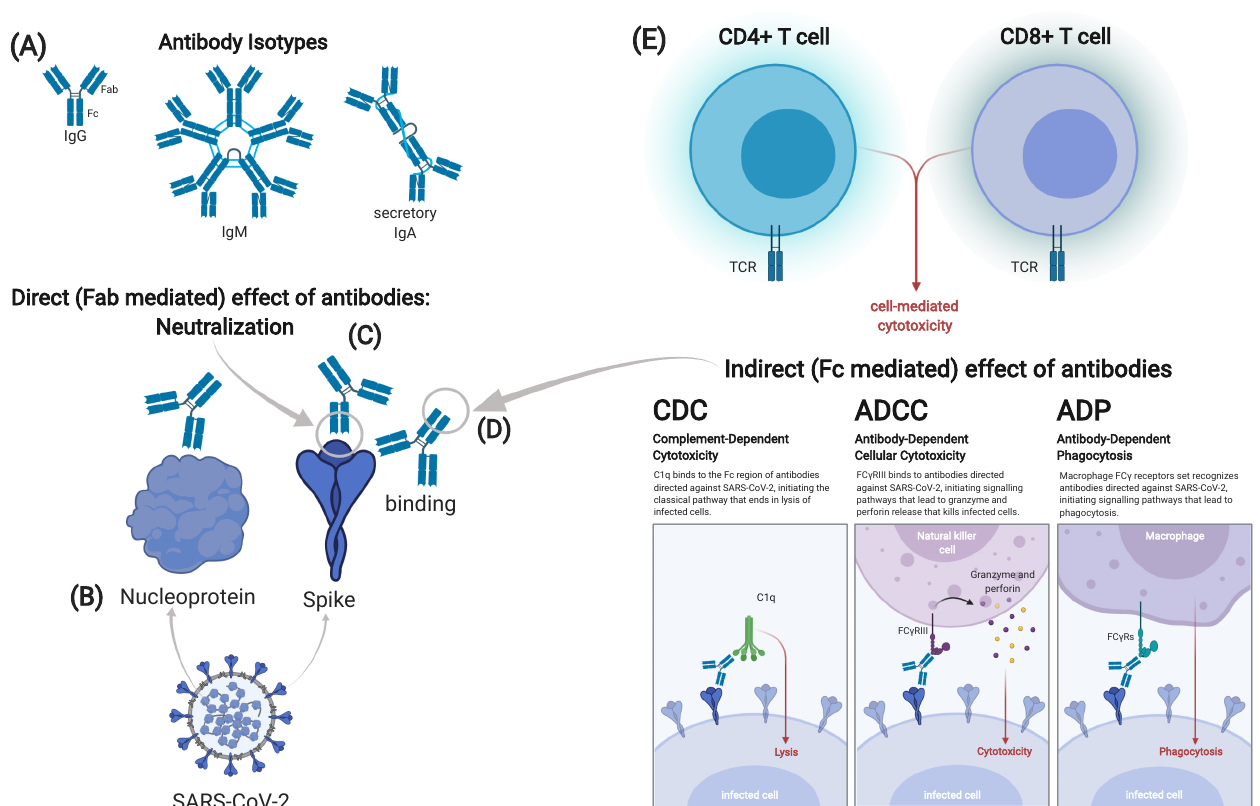
Figure 3. Possible correlates of protection against SARS-CoV-2. Different isotypes of antibodies can be identified after vaccination or infection. Immunoglobulin (Ig)G and IgM are found in serum, while secretory IgA in its dimeric form is found on mucous membranes ( A ). Antibodies can target either the spike or other viral proteins, e.g., the nucleoprotein ( B ). Effect of antibodies can either be direct, mediated through the fragment antigen binding (Fab) part of the antibody ( C ) or indirect, mediated by the fragment crystallizable (Fc) part ( D ). The latter includes complement-dependent cytotoxicity (CDC), antibody dependent cell-mediated cytotoxicity antibodies (ADCC) and antibody-dependent phagocytosis (ADP). Cellular immune responses can be divided in CD4+ and CD8+ T-cell responses ( E ). Correlates of protection may differ in infection and vaccination, maybe even between different types of vaccines. Graphic created at biorender.com including adapted template from Daniela Rothschild